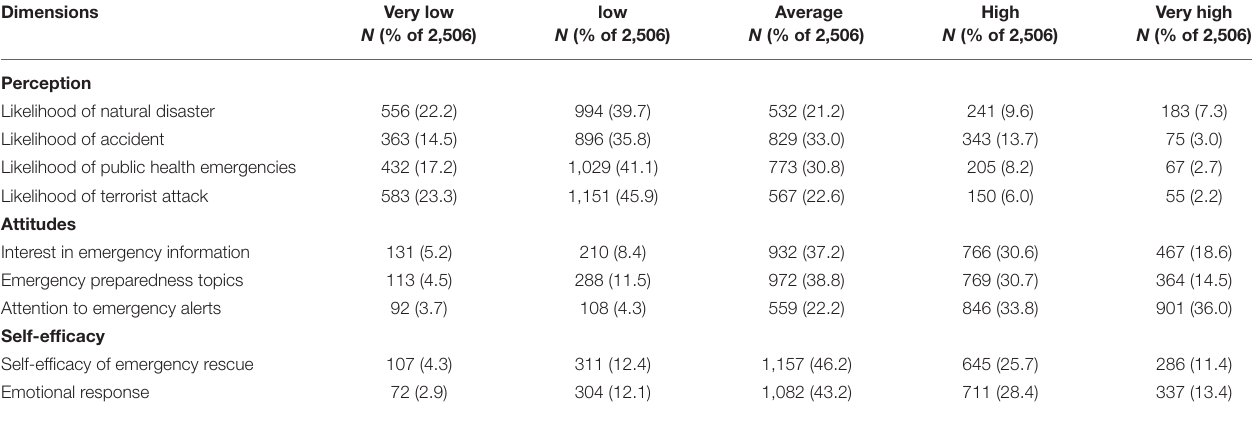
TABLE 2 | Perception, attitudes and self-efficacy of respondents toward emergency preparedness.